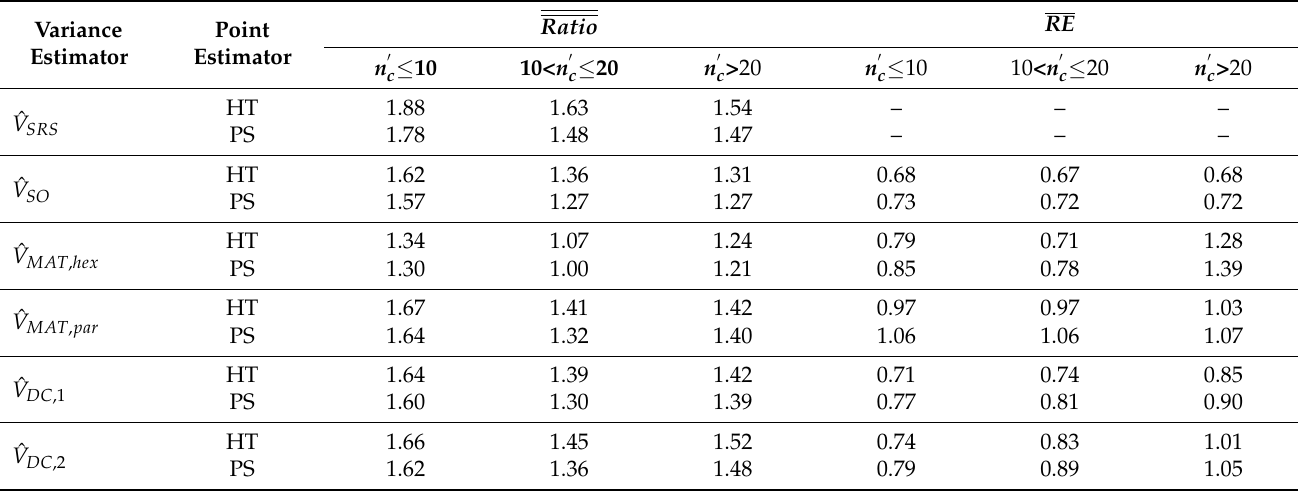
Table 4. Ratio and RE disaggregated by the small domain sample size class for all estimators under the HT and PS